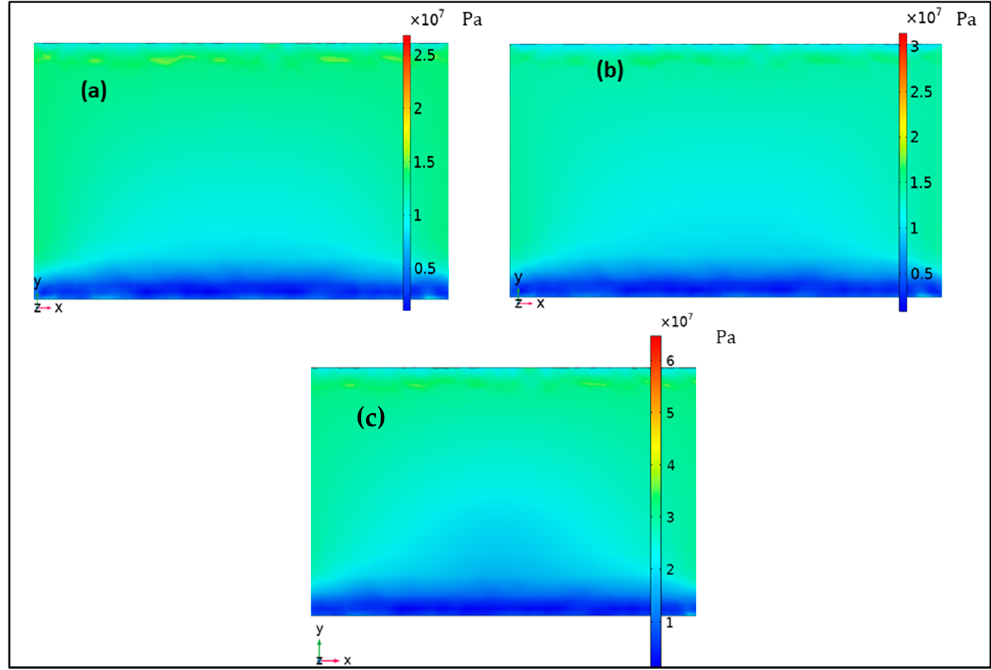
Figure 4. The distribution of stress in PZT-5H piezo film of the nonlinear PEHs: ( a ) rectangular, ( b ) tapered, and ( c ) exsect-tapered.